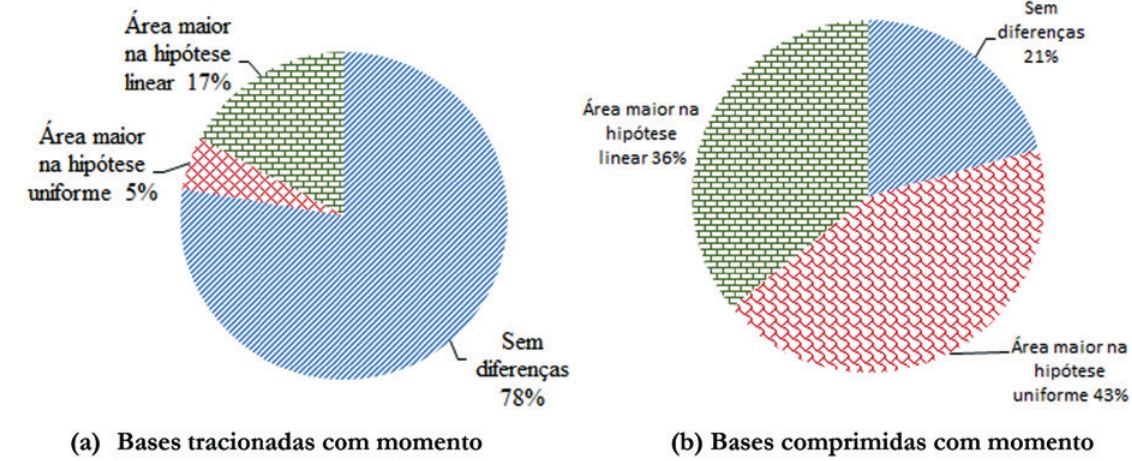
Gráfico da linha de ajuste perfeito para a área das placas de